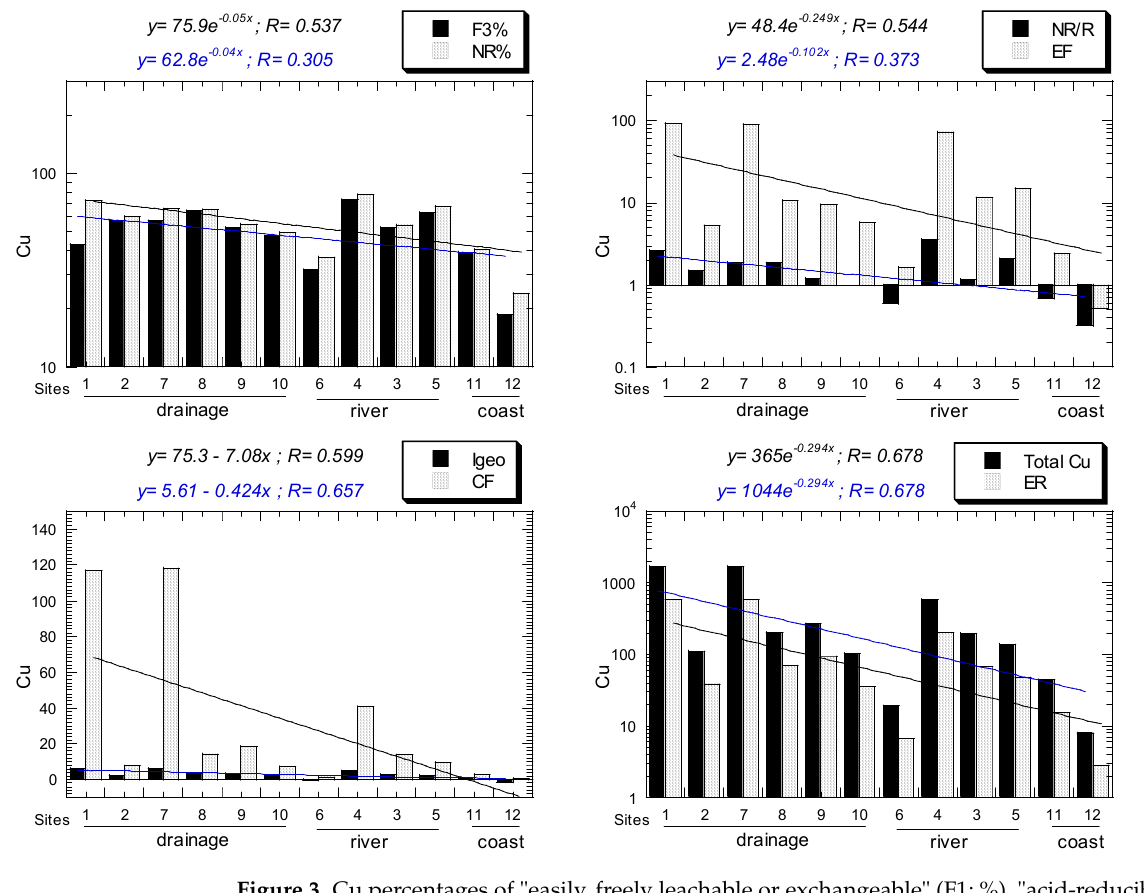
Figure 3. Cu percentages of "easily, freely leachable or exchangeable" (F1; %), "acid-reducible" (F2;